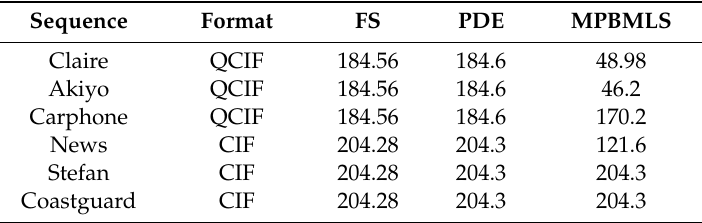
Table 1. Mean value of search points per MB of size 16 × 16. CIF and QCIF correspond to the common intermediate format and quarter common intermediate format, respectively.